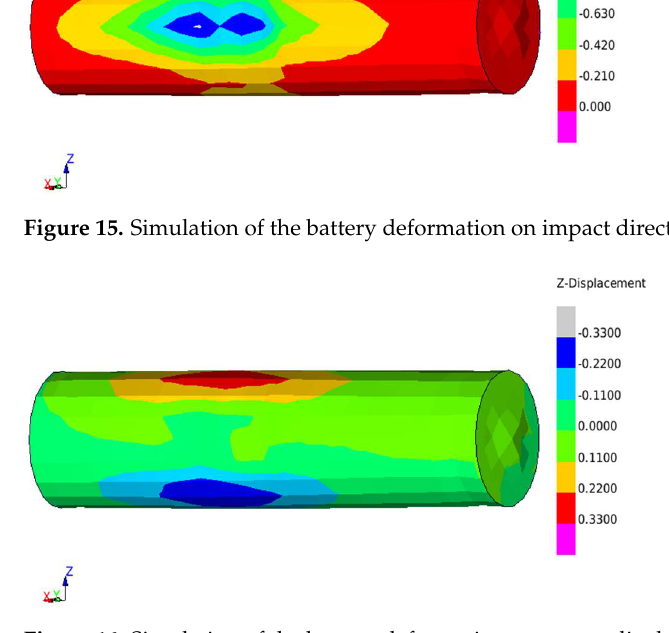
Figure 16. Simulation of the battery deformation on perpendicular impact direction.